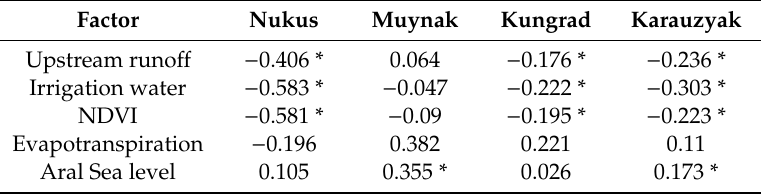
Table 1. The correlation coe ffi cient between the monthly average groundwater level and upstream runo ff , irrigation water, NDVI, evapotranspiration, and Aral Sea level in the Amu Darya Delta. Factor Nukus Muynak Kungrad Karauzyak Upstream runo ff − 0.406 * 0.064 − 0.176 * − 0.236 * Irrigation water − 0.583* − 0.047 − 0.222* − 0.303* NDVI Evapotranspiration − 0.196 0.382 0.221 0.11 Aral Sea level 0.105 0.355* 0.026